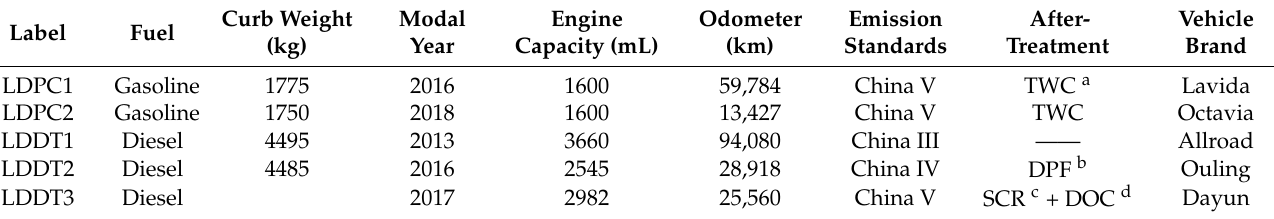
Table 1. Specifications of test